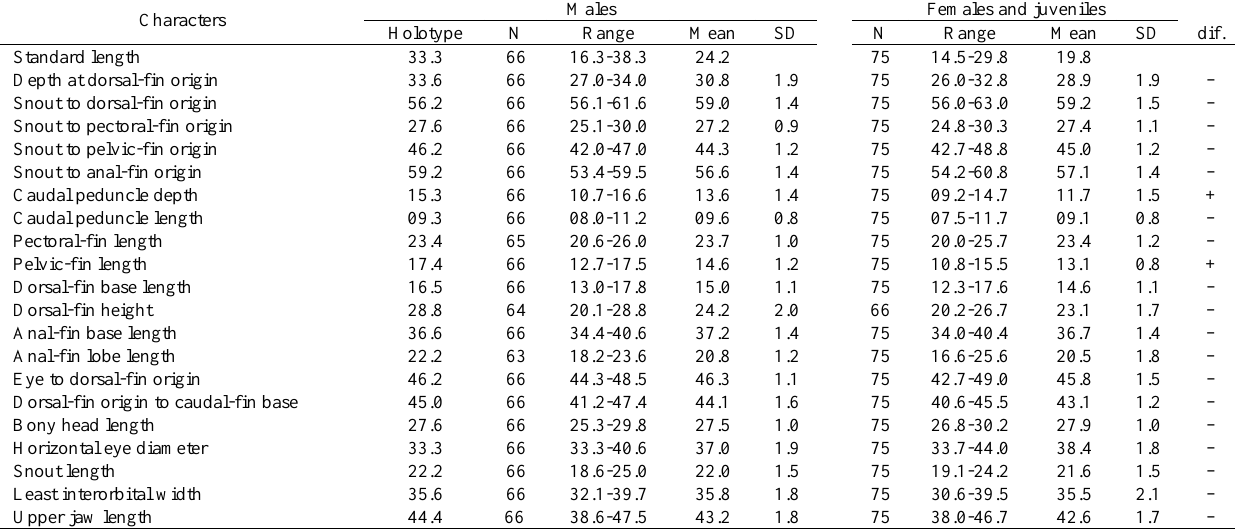
Table 6. Morphometrics of Mimagoniates inequalis (Eigenmann). Standard length is expressed in mm; measurements through bony head length are percentages of standard length; the last four entries are percentages of head length. A plus sign under the abbreviation dif indicates there is a significant statistical difference between the males and females in the particular character indicated. Specimens are from within approximately 70 km of Porto Alegre from the north side of the rio Jacuí and laguna dos Patos, Rio Grande do Sul, Brasil, FMNH 54893 (holotype of Glandulocauda inequalis Eigenmann), FMNH 54894, CAS (IUM) 13270 (paratypes of G . inequalis ), MAPA 811, MZUSP 26908, MZUSP 83355, USNM 254273, USNM 254274 and from Rivera, Uruguay, USNM uncatalogued. SD = Standard